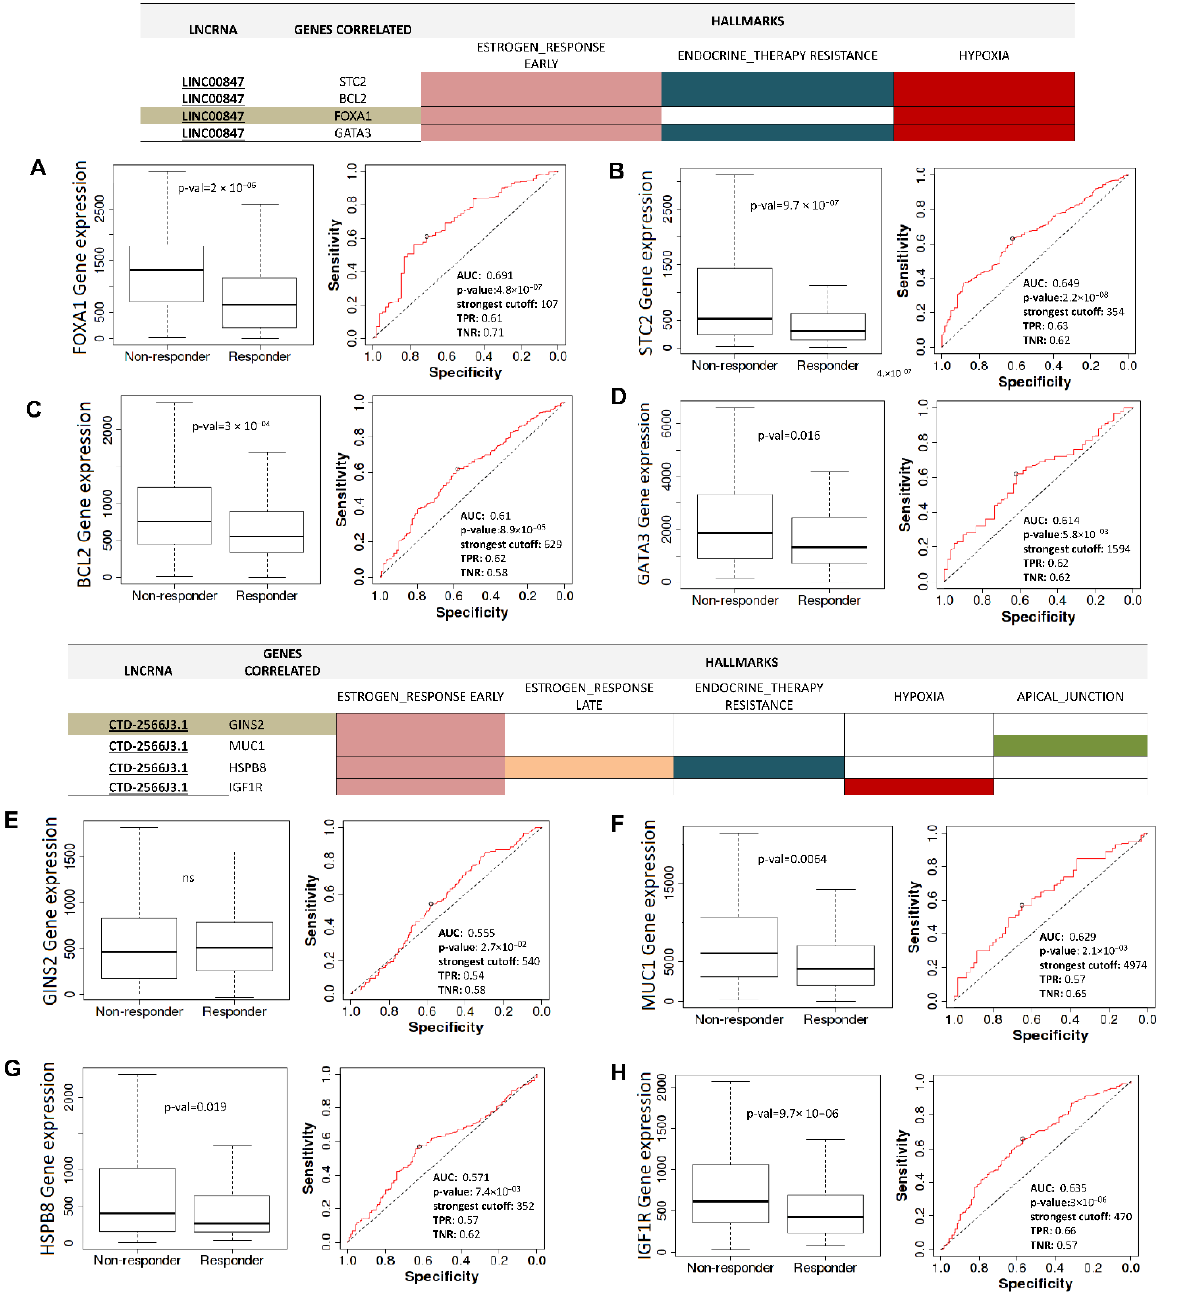
Figure 9. Pathological complete response related to lncRNAs/mRNAs pairs co-expressed in 3D cultures and breast cancer Luminal B tumors. ( A – D ) Gene expression of mRNAs related to LINC00847 in non-responder and responder and ROC values. ( E – H ) Gene expression of mRNAs related to CTD-2566J3.1 in non-responder and responder and ROC values.